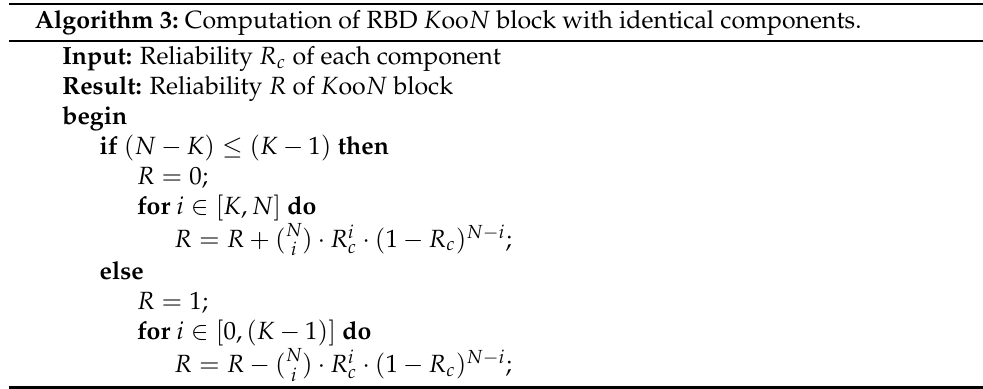
Algorithm 3: Computation of RBD K oo N block with identical